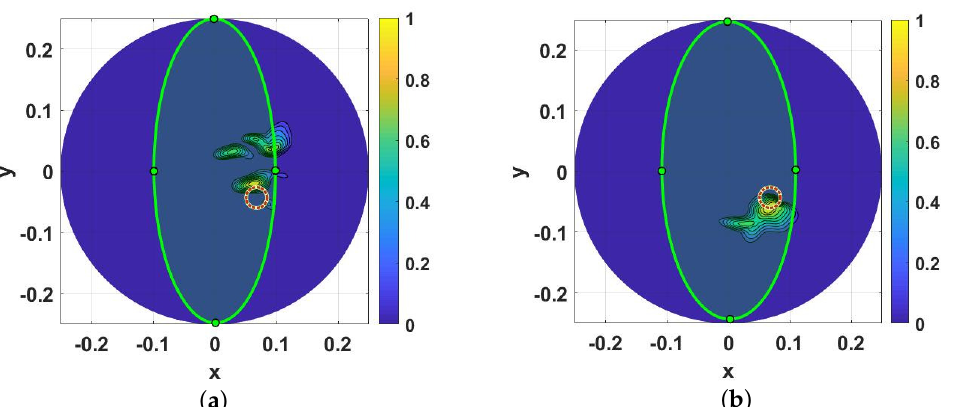
Figure 4. Obtained microwave images of anechoic chamber phantom experiments using frequency 1 GHz to 5 GHz, ( a ) applying “rotation subtraction” method, ( b ) employing the “ideal” method. The light green ellipse indicates the phantom region, while the area marked with a red circle shows the exact position of inclusion and the dimension of the circle is in relation to the dimension of the inclusion. Axes scales are meters.